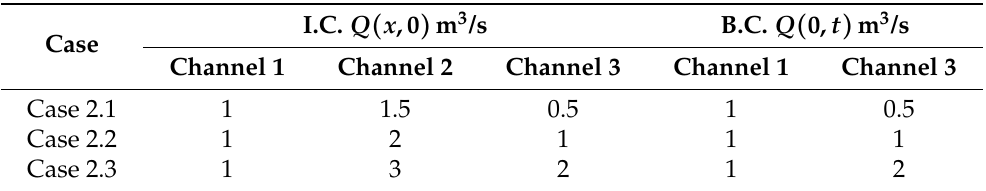
Table 1. Initial and inlet boundary conditions to evaluate the reconstruction of the inlet boundary condition of the solute at channel